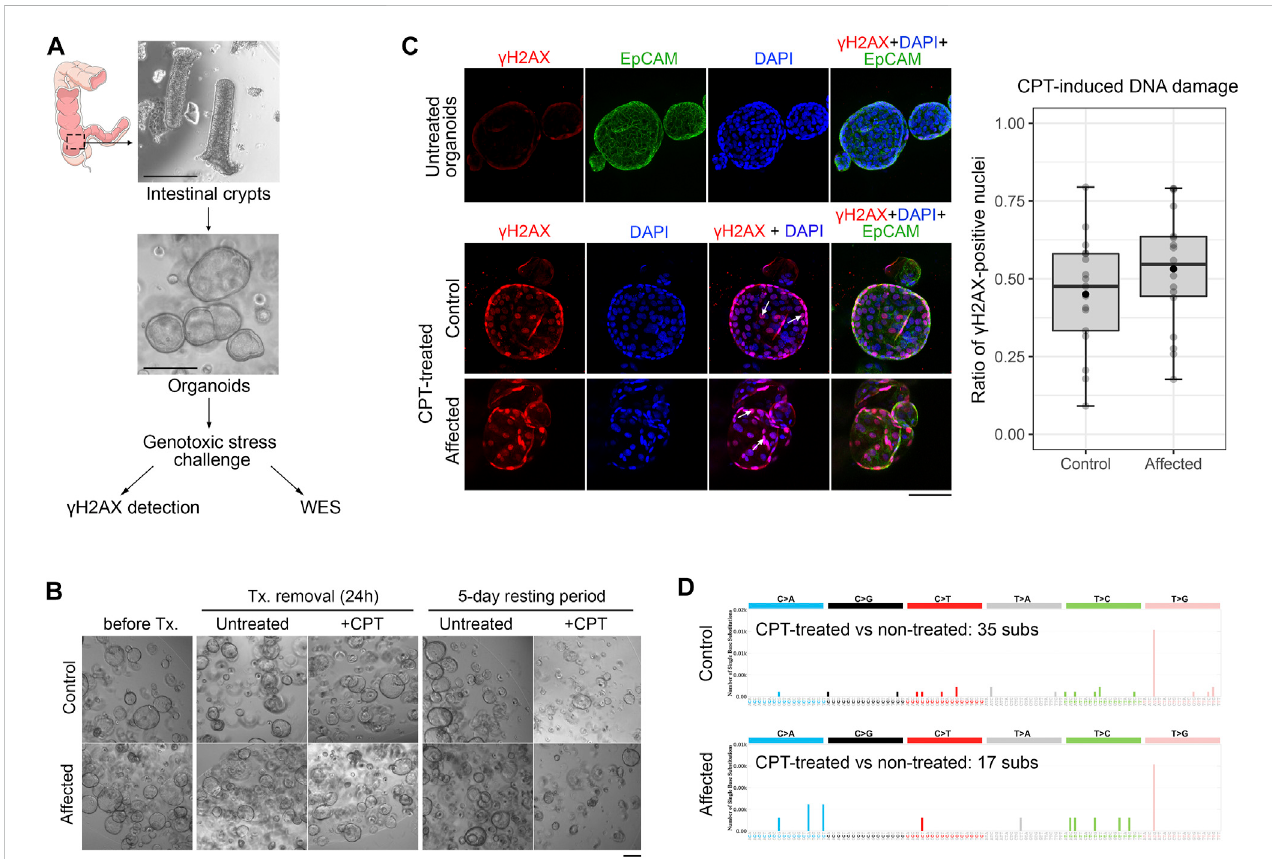
FIGURE 4 Generation of PDO and DNA damage and repair functional assessment in a POLD1 p.Lys648fs*46 carrier. (A) Overview of the PDO generation and functional characterization work fl ow. Endoscopic samples from the index case ( POLD1 p.Lys648fs*46 carrier, Affected) and a healthy control were used to generate PDO. Organoids were subsequently exposed to CPT in order to induce genotoxic stress and evaluated for DNA damage ( γ H2AX) and DNA repair (WES) after a 5-day resting period. Scale bars, 200 µm. (B) Representative images of PDO from control and POLD1 p.Lys648fs*46 carrier (Affected) at different stages of the experiment. Panel scale bar, 200 µm. (C) DNA damage assessment after CPT treatment by γ H2AX immuno fl uorescence staining. γ H2AX-DAPI colocalization (white arrows) was assessed and γ H2AX-positive nuclei were quanti fi ed. EpCAM counterstaining was also performed. Untreated organoids showed negligible γ H2AX signal (representative image of control organoids is displayed). Panel scale bar, 100 µm. (D) DNA repair assessment by WES after CPT-treatment and a 5-day resting period. The pro fi les of the mutational signatures are depicted. CPT, camptothecin; Tx, treatment; WES, whole- exome